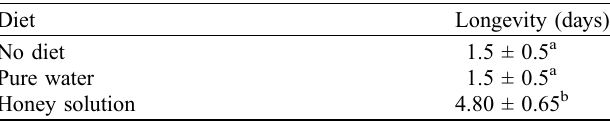
Table 1. Longevity of female Quadrastichus mendeli fed on different